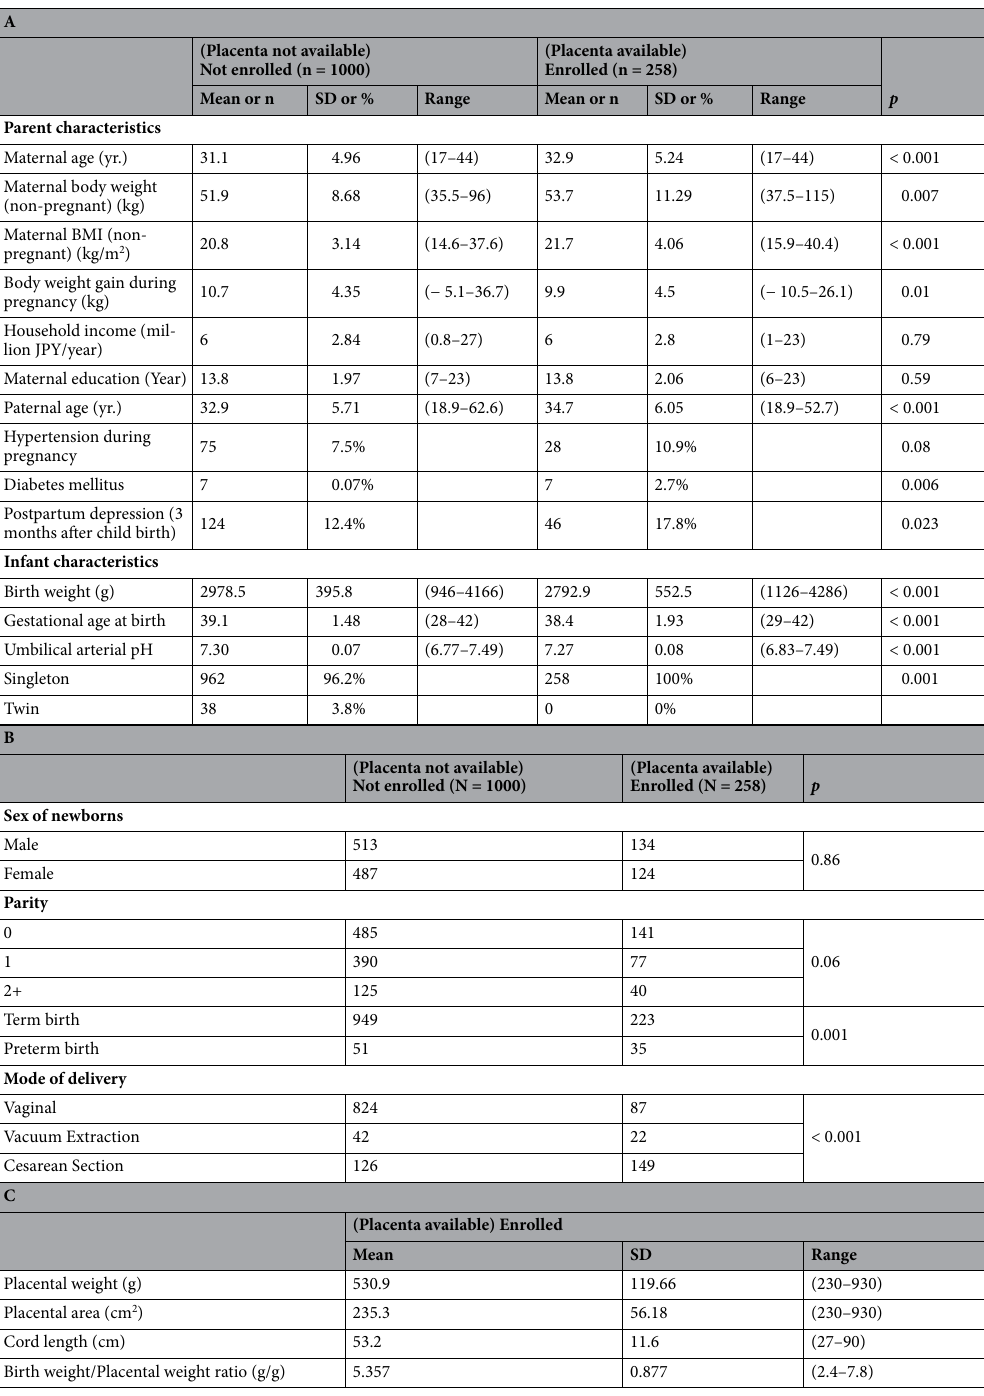
Table 2. Perinatal backgrounds of parents and infants. For hypertension during pregnancy, gestation diabetes mellitus, postpartum depression, singleton and twin, n and percentages (in parentheses) were